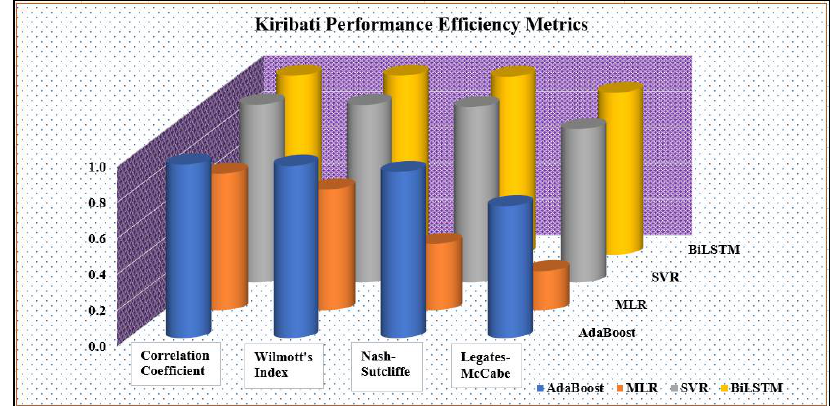
Figure 13. Bar chart of model performance for Kiribati.